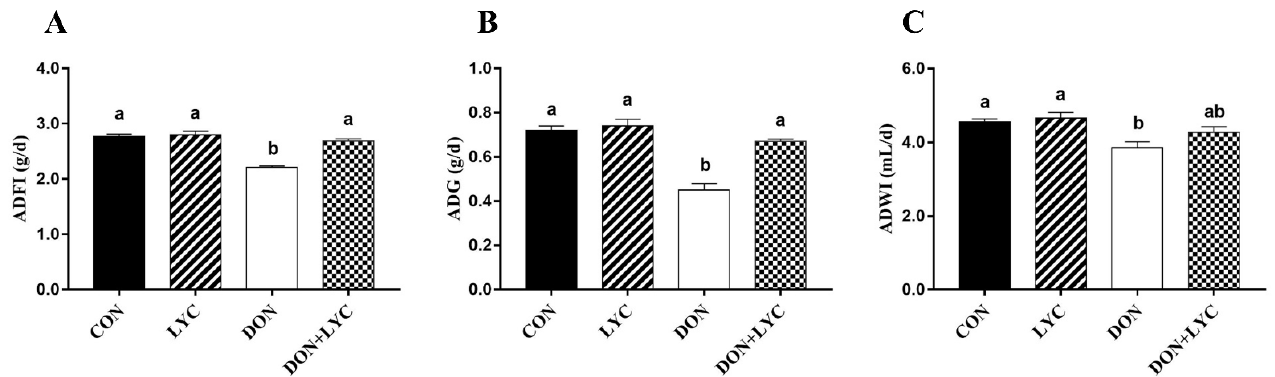
Figure 1. LYC treatment improves the growth performance of mice exposed to DON. ( A ) ADF1, ( B ) ADG, and ( C ) ADWI. The results are presented as mean ± SEM ( n = 12). Columns with different superscripts letters indicating significant difference ( p < 0.05).